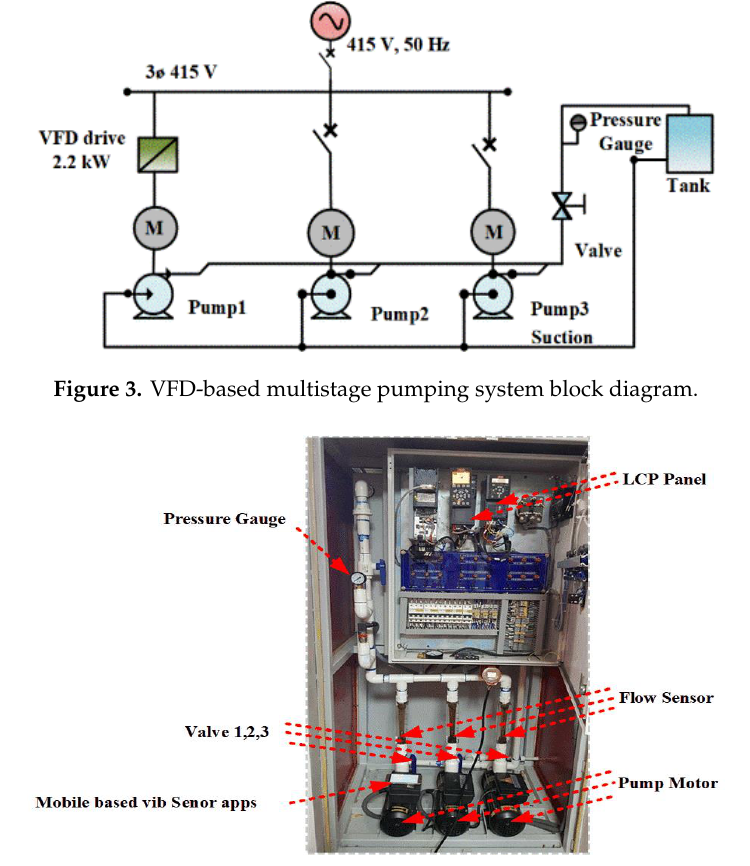
Figure 4. Experimental pumping set-up .